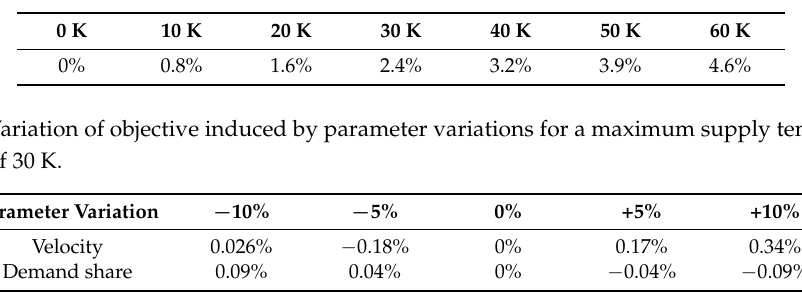
Table 2. Savings for different maximum increases of supply temperature.